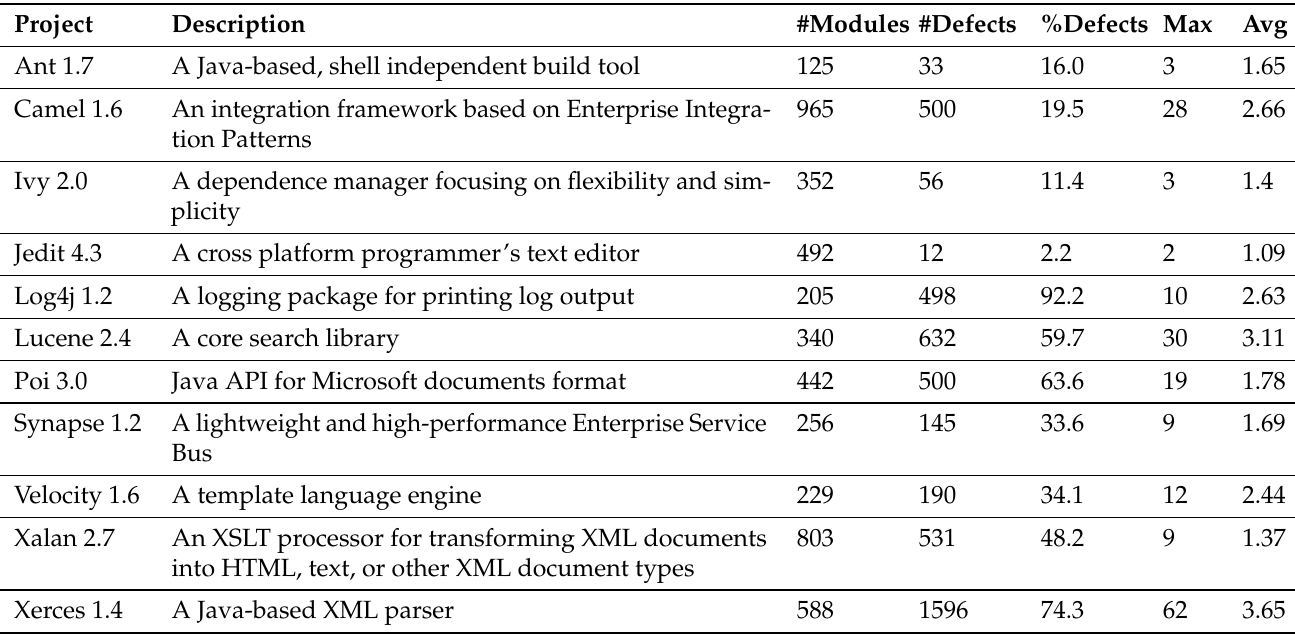
Table 1. Details of Experiment